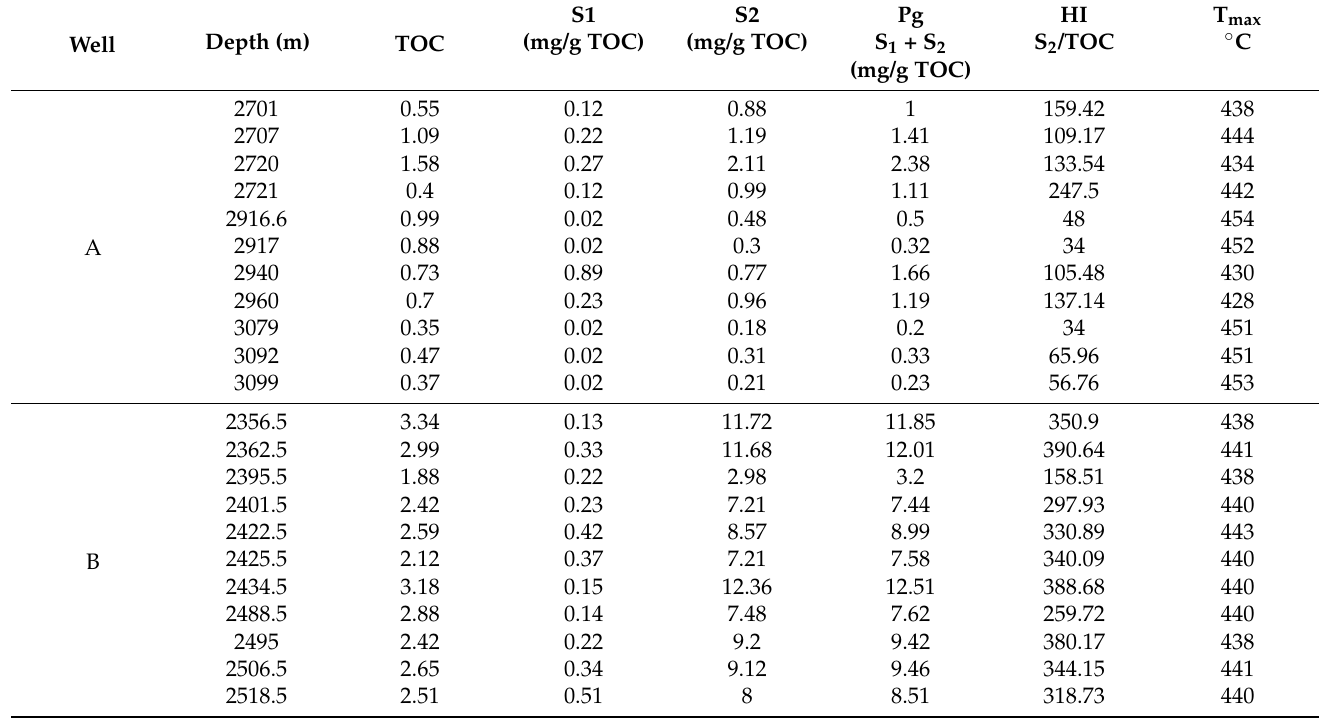
Table 2. Results from geochemical Rock-Eval/TOC analysis with calculated parameters from Yueguifeng